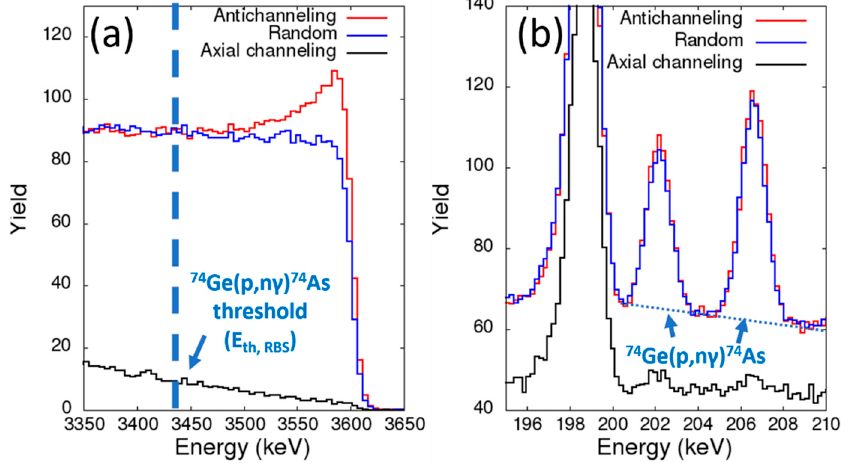
Figure 3 . Rutherford Backscattering of protons incident at 3.80 MeV (RBS, a) and γ -radiation (b) measured online at different alignment conditions (antichanneling, random orientation, axial channeling). Yield is normalized to 1 μ C of incoming